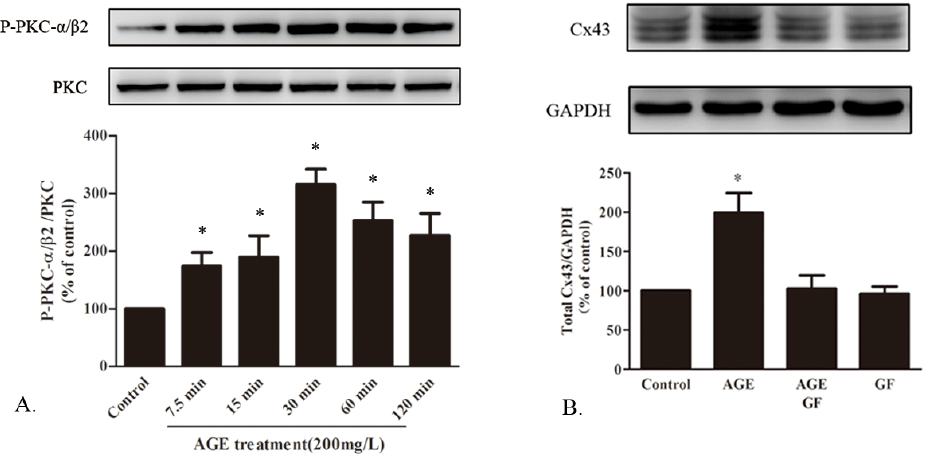
Figure 7. The involvement of the PKC pathway in the effect of AGE on Cx43 expression. ( A ) AGE activated the time-dependent phosphorylation of PKC α / β 2 in cardiomyocytes assessed by Western blot; ( B ) Cx43 protein expression in cells treated by AGE for 24 h with the presence of PKC inhibitor GF109203X (GF, 10 μ M). * p < 0.05 vs. control; Data are mean ±